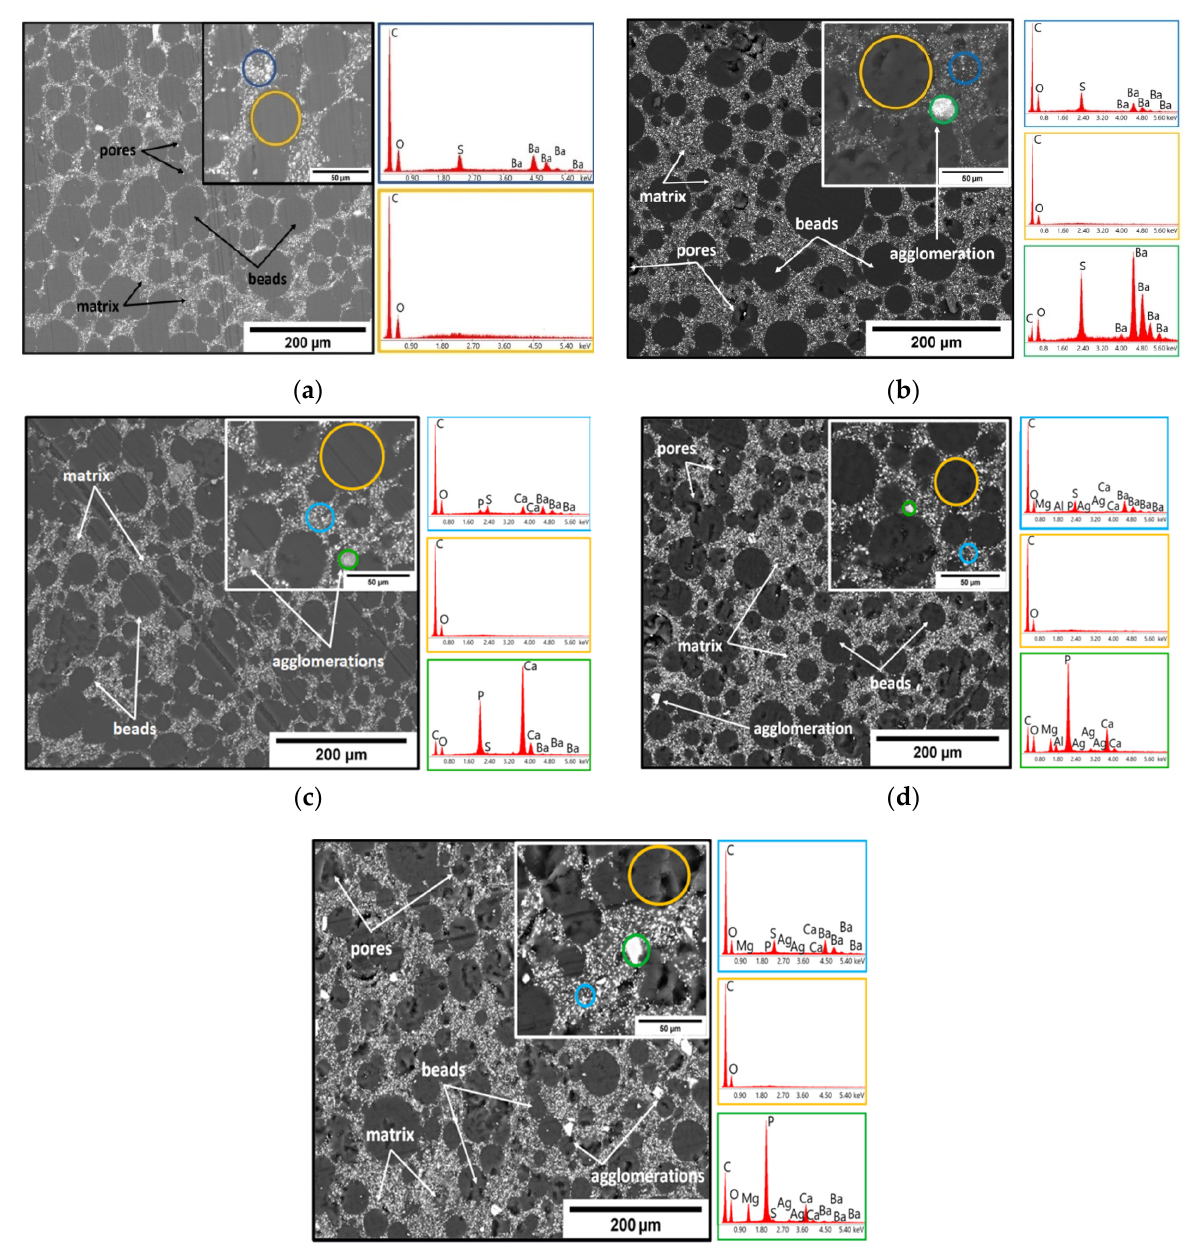
Figure 2. Representative SEM images and corresponding EDS spectra obtained from the highlighted areas of the experi- mental samples: ( a ) R sample; ( b ) GM sample; ( c ) HUM sample; ( d ) AM1 sample; ( e ) AM2 sample. Table 2. Contact angle values for experimental bone cement